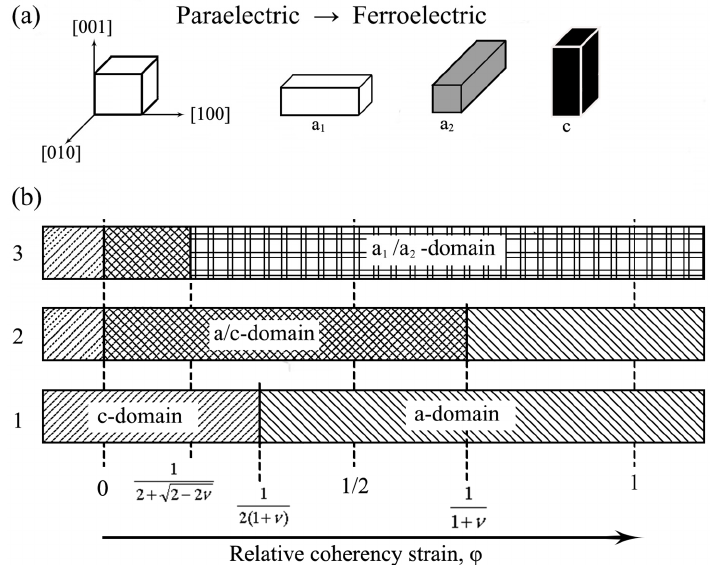
Figure 6. Domain states in tetragonal PTFs. ( a ) Three domain states in tetragonal PTFs: a 1 -domain with [100] polarization; a 2 -domain with [010] polarization; c-domain with [001] polarization. ( b ) Theoretical calculation for predicting domain states with different φ in tetragonal PTFs. From bottom to top, (1) single domain state, (2) two domain state of a-domain, and c-domain, and (3) the distinction between a 1 -domain and a 2 -domain are taken into account, respectively. Reprinted with permission from [107] 2010 Springer Nature.